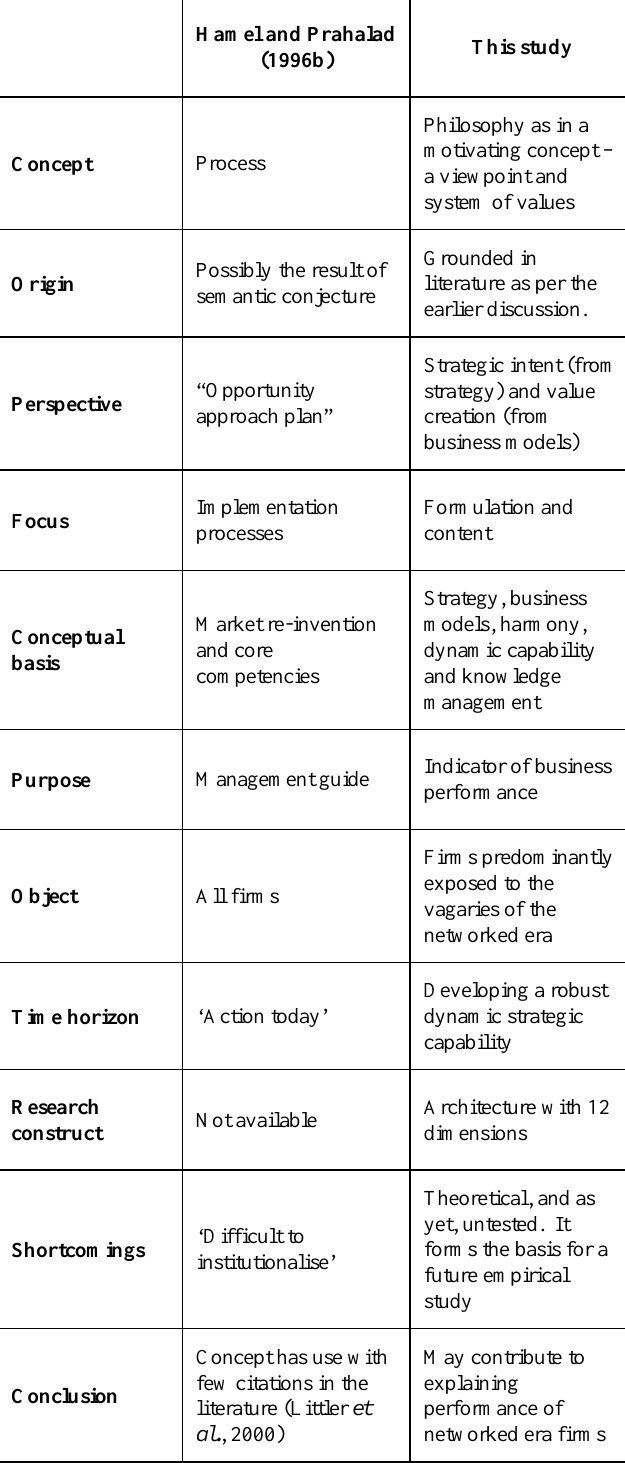
Table 1: Conceptual differences in the strategic architecture